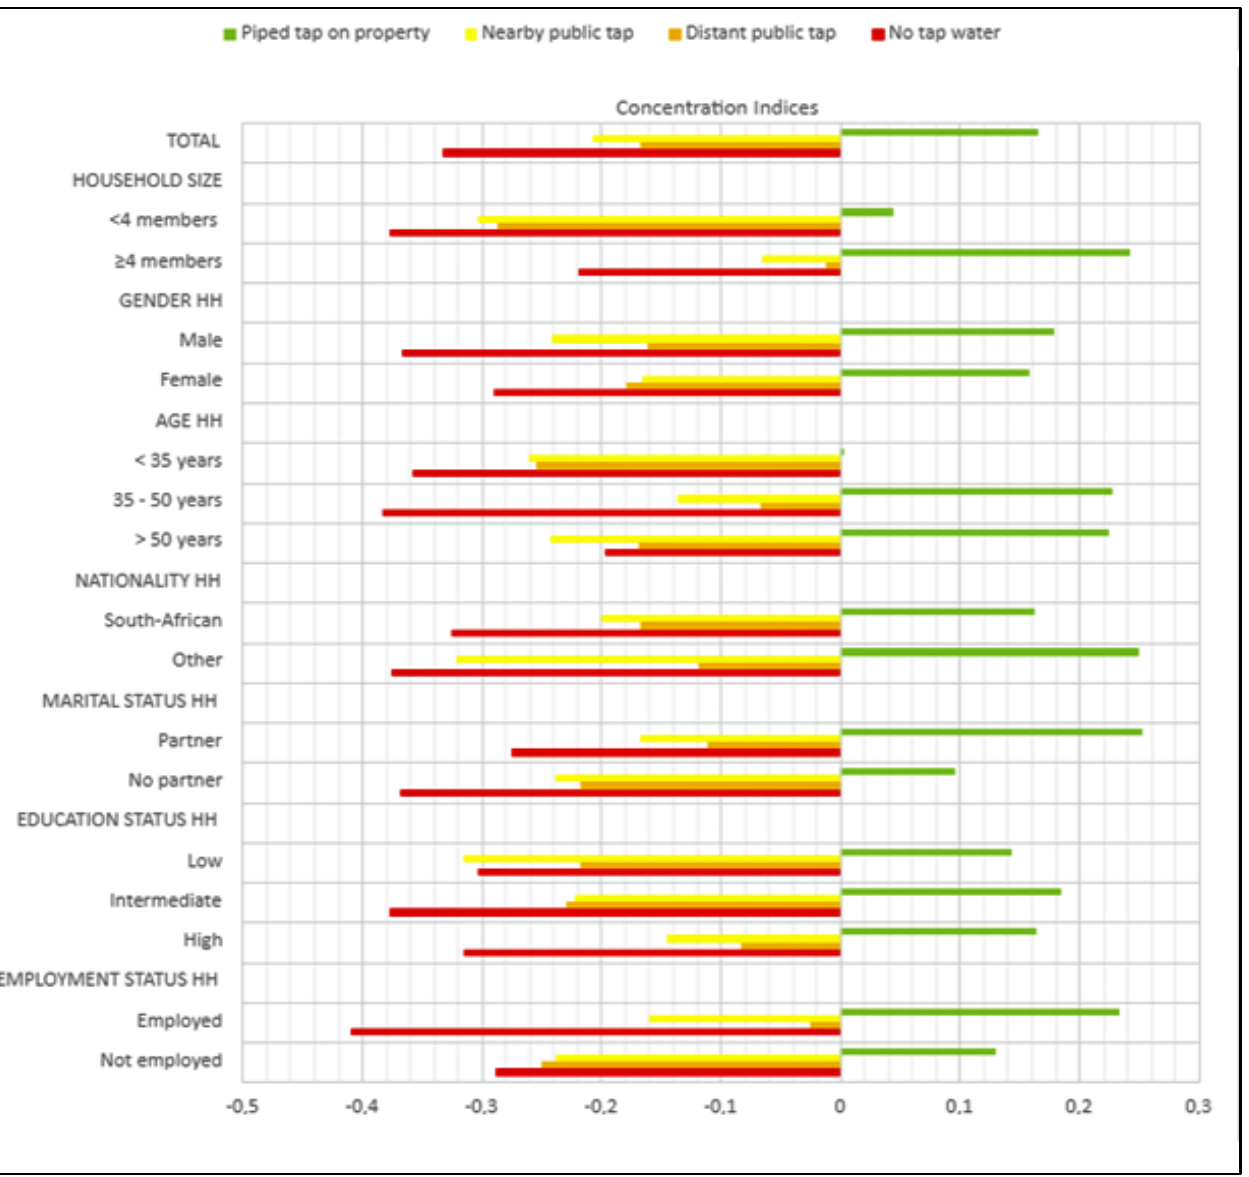
Figure A1. Concentration indices for different population subgroups; HH = household head.